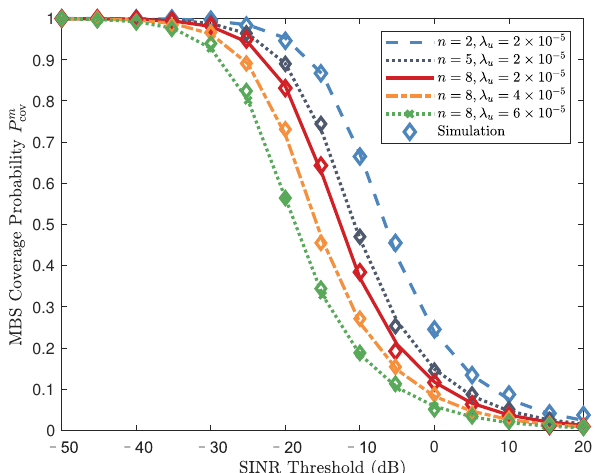
Figure 4. The coverage probability of the MBS with differenet SINR threshold γ u and different numbers of EUUs n within each cluster; the cluster radius a = 50 m; the transmit power of EUUs is 10